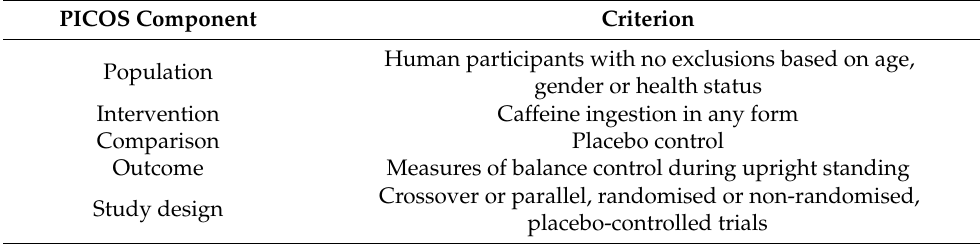
Table 1. PICOS method used to formulate eligibility criteria.